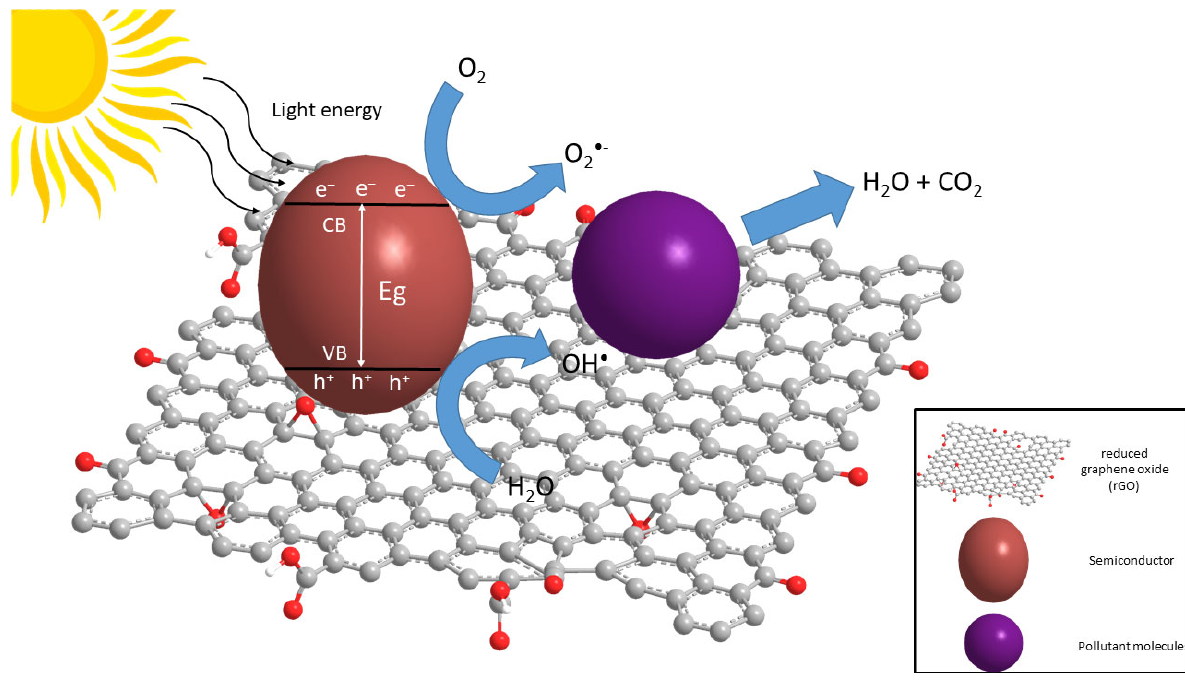
Figure 6. A proposed mechanism for the photodegradation of various organic pollutants over semiconductor ‐ rGO com ‐ posite under solar light irradiation.